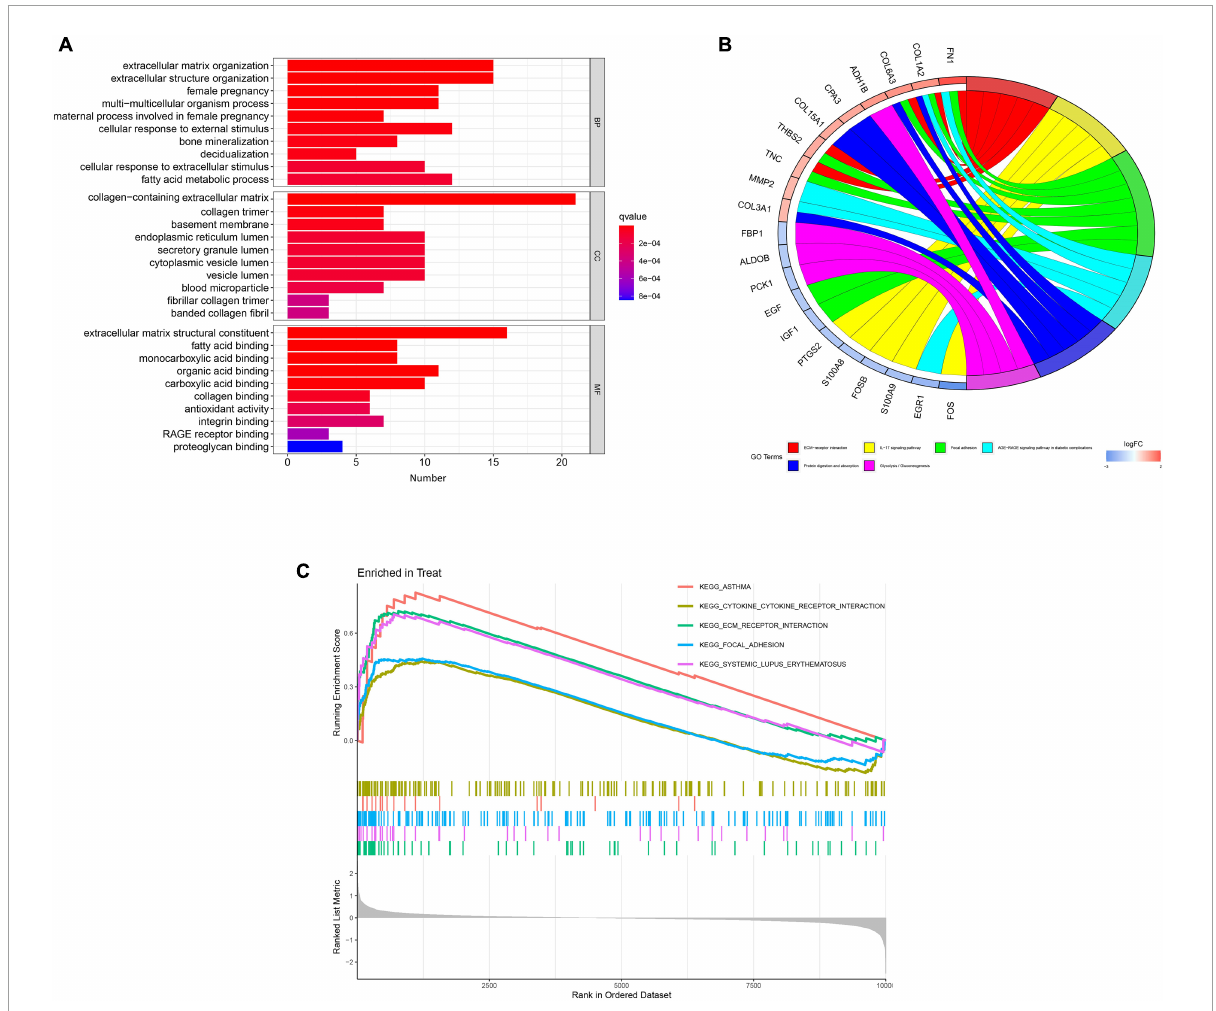
FIGURE3 Results of functional enrichment analyses. (A) Gene Ontology enrichment analysis of the differentially expressed genes. (B) Kyoto Encyclopedia of Genes and Genomes pathway enrichment analysis results. (C) Gene set enrichment analysis (GSEA) profiles, showing the five significant GSEA